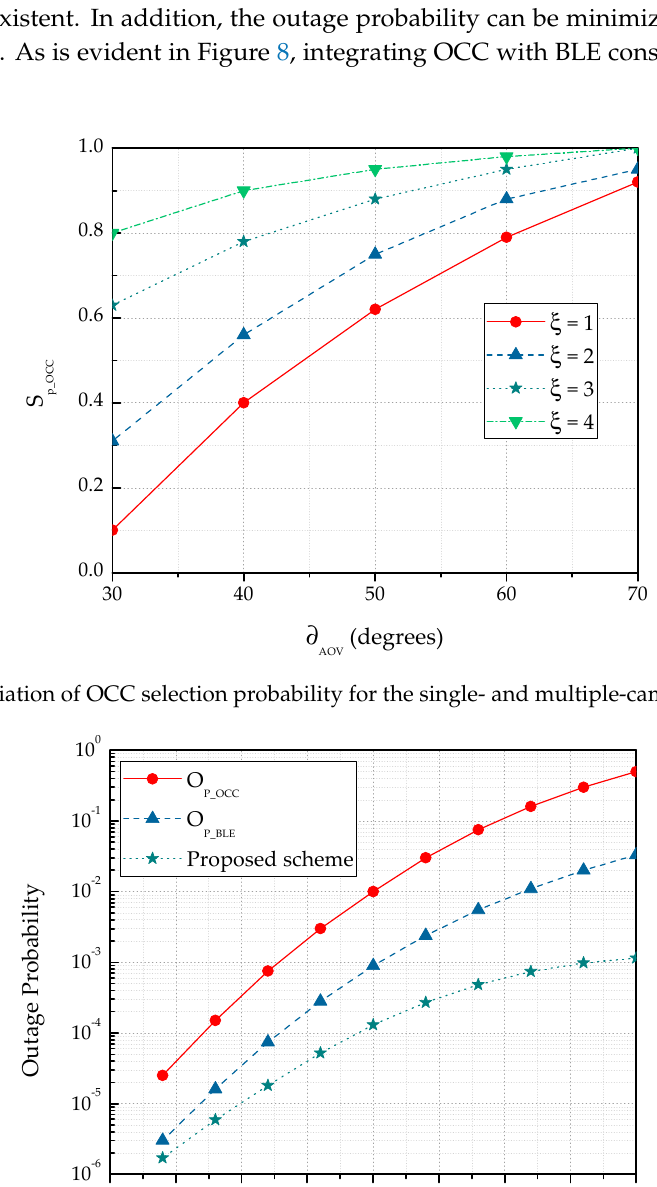
Network switching becomes important when monitoring mobile patients in these scenarios.